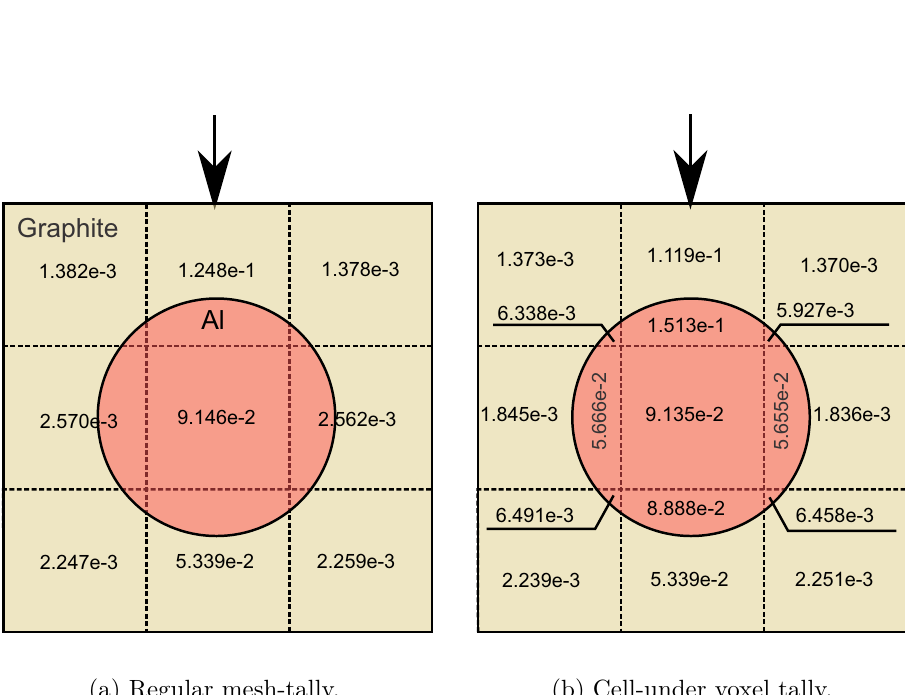
Figure 2: Comparison of neutron fluxes using different tallying approaches with 20 MeV unidirectional neutron beam incident upon a 10 cm × 10 cm × 10 cm graphite cube, with a cylindrical aluminium insert with 5 cm diameter. Values per source neutron. Differences in center value due to stochastic volume